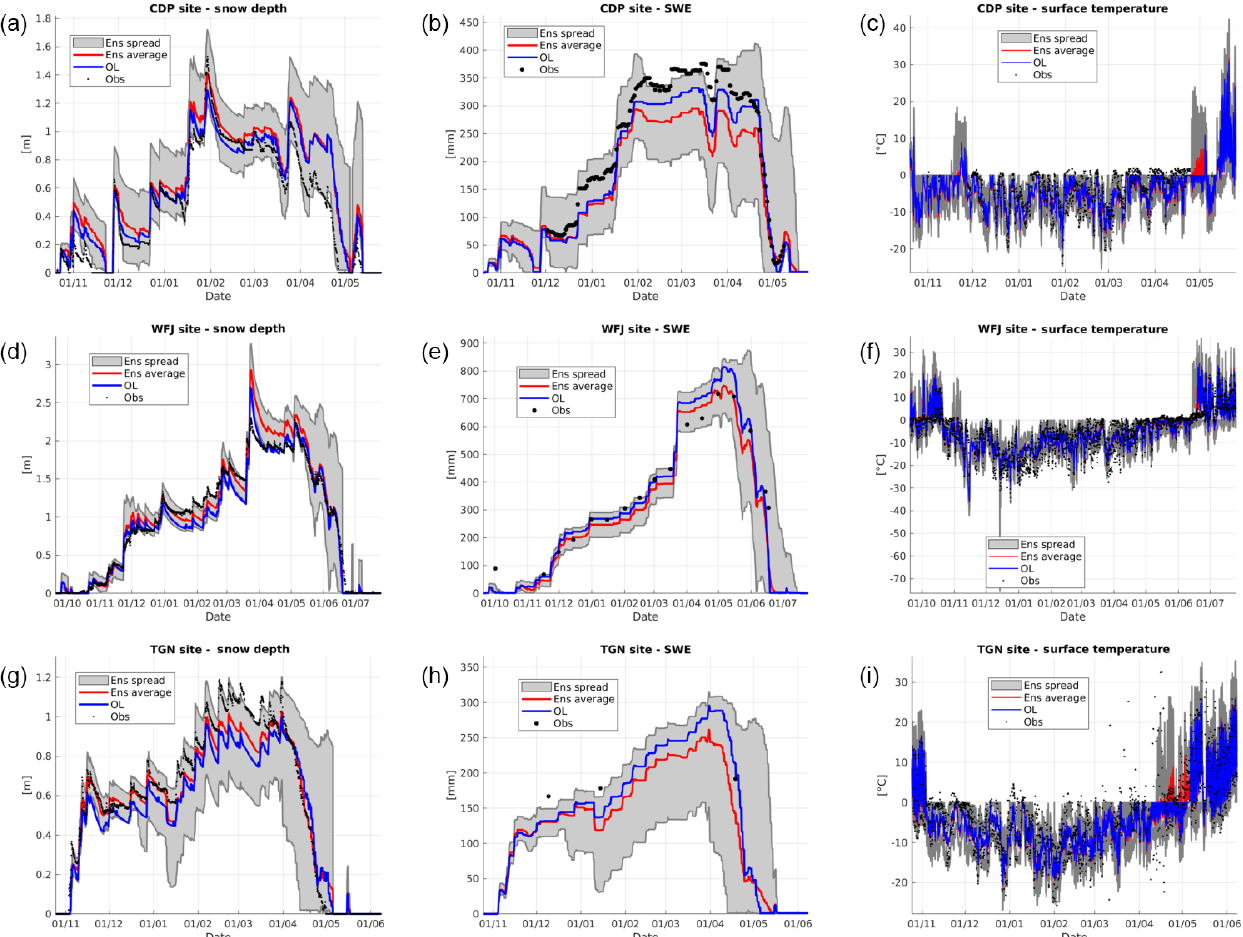
Figure 5. Impact of the meteorological uncertainty: ensemble simulations of snow depth (a, d, g) , SWE (b, e, h) , and surface temperature (c, f, i) at CDP, winter 2003/2004 (a, b, c) ; WFJ, winter 2001/2002 (d, e, f) ; and TGN, winter 2014/2015 (g, h, i)